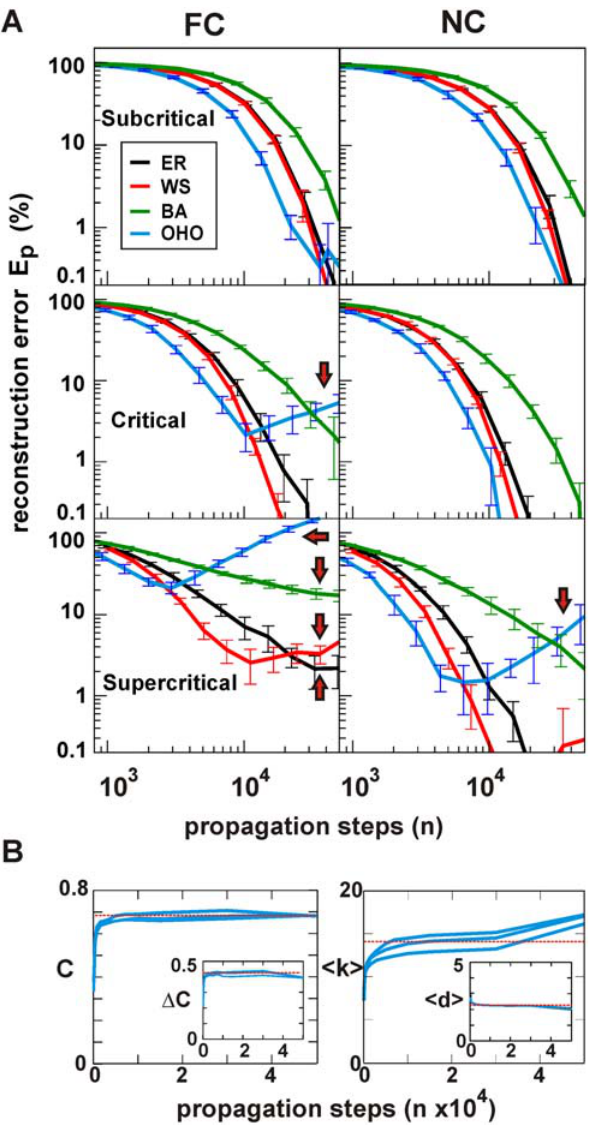
Figure 5. The NC algorithm reconstructs random and most small-world network topologies in all three dynamical regimes. (A) Comparison in reconstruction efficacy between the FC (left) and the NC algorithm (right; N ~ 60, S k d T ~ 10, p d ~ 0 : 1, z ~ 1 , 20% noise). E p is plotted against the number of propagation steps. FC fails to reconstruct the OHO topology in the critical regime and any of the small-world topologies in the supercritical regime (red arrows). In contrast, NC robustly performs in the critical and supercritical regime for most topologies. Note plot of E p down to 0.1%. (B) Effect of large E p on basic network properties. The clustering coefficient C and excess clustering coefficient D C (inset) approach the real values (broken red lines) with increasing number of propagation steps (left). NC reconstruction of the OHO network in A in the supercritical regime. Right: Corresponding analysis for S k d T and mean path length S d T . The increase in E p above 30,000 propagation steps barely affects C , despite slightly increasing S k d T and decreasing S d T . (n=3 network simulations).